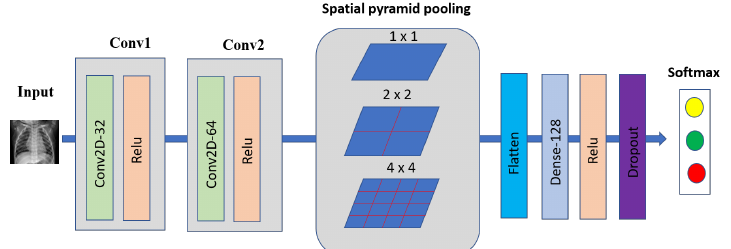
Figure 3. The 2D CNN with 3 × 3 convolutional layers and SPP